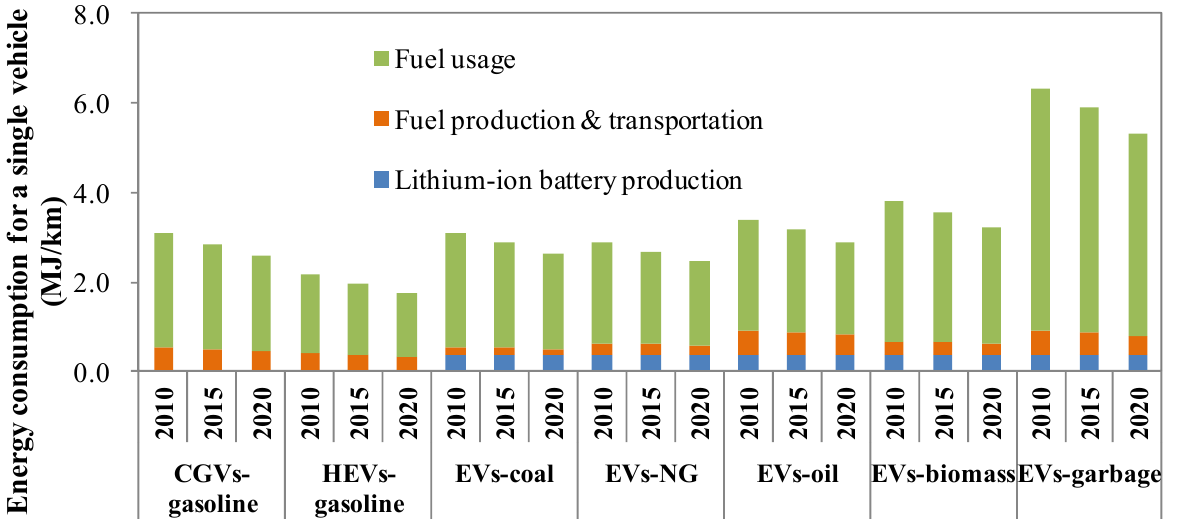
Figure 2. Energy consumption for a single vehicle (HEVs-gasoline means the hybrid electric vehicles using gasoline, EVs-fuel means the electric vehicles using the electricity generated by fuel